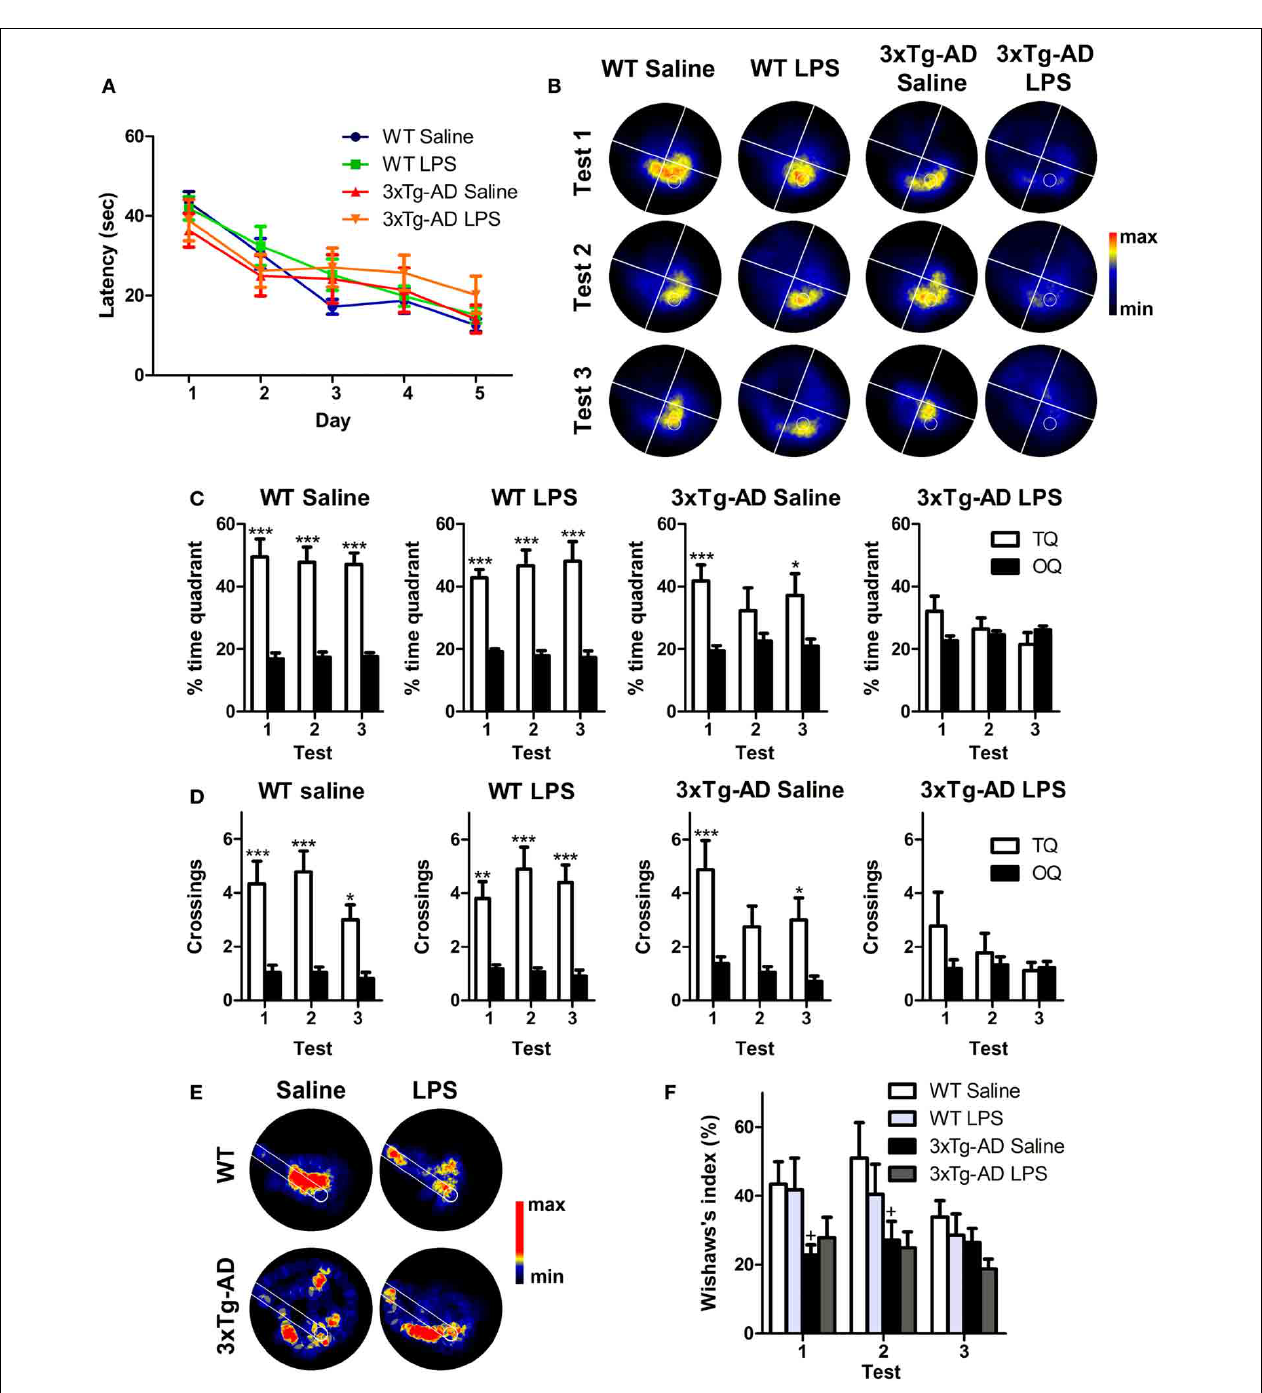
FIGURE 2 | Long-term detrimental effect of LPS on spatial memory of 3xTg-AD mouse. (A) Performance of WT ( n = 9), 3xTg-AD ( n = 8) and LPS-treatedWT( n = 10)and3xTg-AD( n = 9)miceimprovedsignificantlyalong MWM training session. (B) Permanency plots showing the probability of mice location (maximum: red color, minimum: black). White lines divide quadrants and white circle indicates platform location. (C,D) Saline and LPS-treated WT mice displayed significantly higher permanencies and crossings in the target quadrant (TQ) compared to the other quadrants (OQ) in all three tests, while